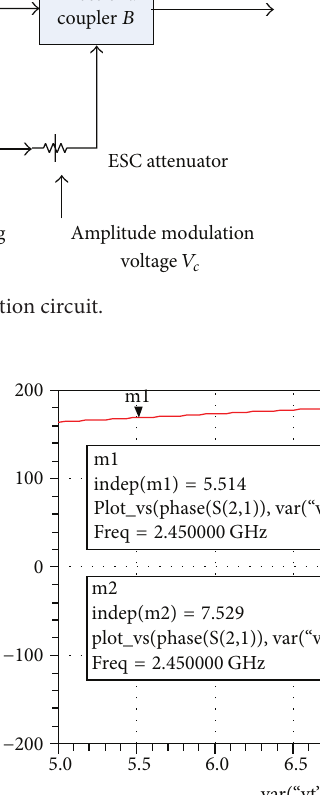
Figure 4: ERC 180 ∘ phase shifter. Figure 5: The voltage control phase shifter; when the phase- controlled voltage 𝑉 𝑝 changes at 5.5 V ∼ 7.5 V, the electrical phase shifter adjusts a phase shift variation of 169.2 ∘ ∼187.4 ∘ ; taking into account the additional phase shift of the circulator and directional coupler itself, the phase control range of the voltage 𝑉 𝑝 may also be larger than the theoretical results, which can meet the overall requirements of the circuit to compensate the phase shift. By carefully adjusting the control voltage 𝑉 𝑝 , the exact 180 ∘ phase shift can be obtained between the transmitter port of the circulator and the cancellation